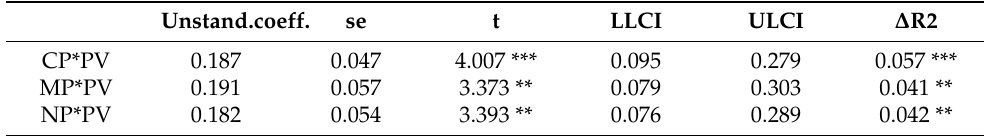
Table 6. Results of Moderation